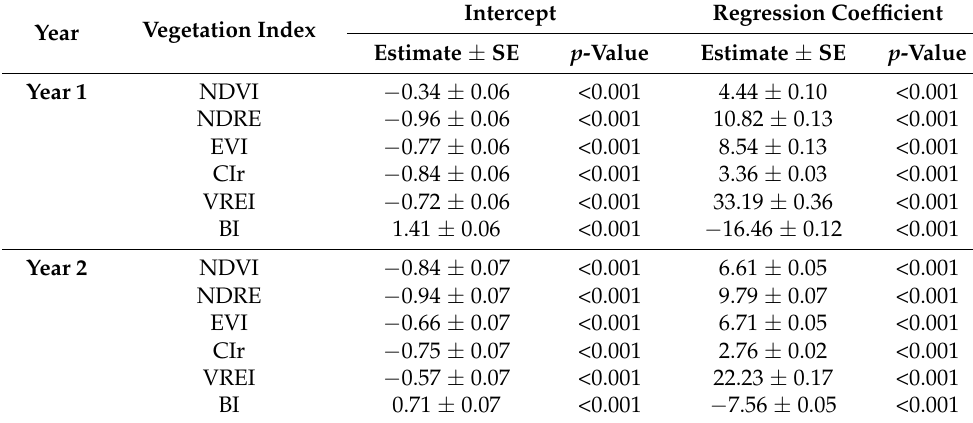
Table 4. Linear mixed-effect regression models of vegetation indices and live weight change of grazing cattle calculated from Sentinel-2 satellite imagery in both experimental years.